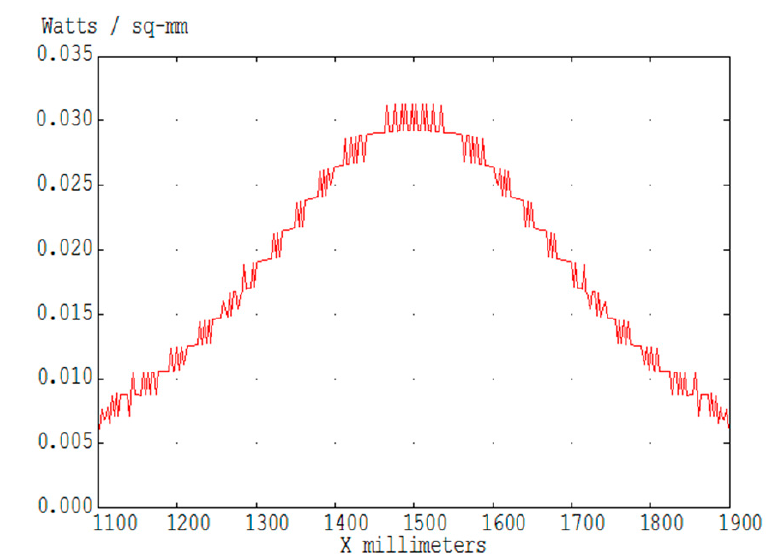
Figure 1. The light intensity distribution with a cylindrical lens group.